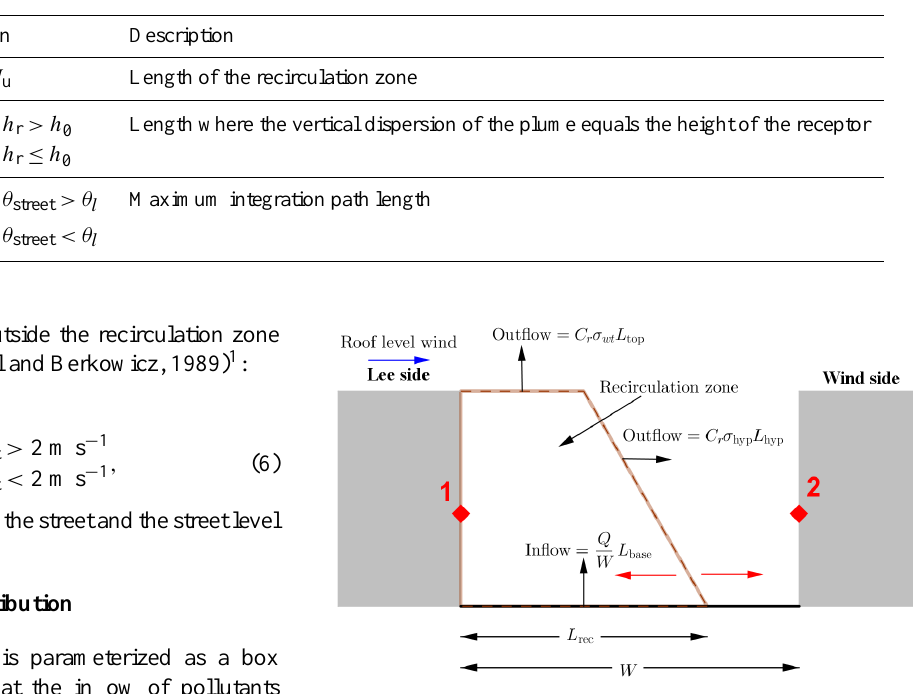
Figure 6. Cross section of a street canyon with the dimensions of the recirculation zone illustrated. The red arrows represent the street level wind direction. Based on Hertel and Berkowicz (1989, p.